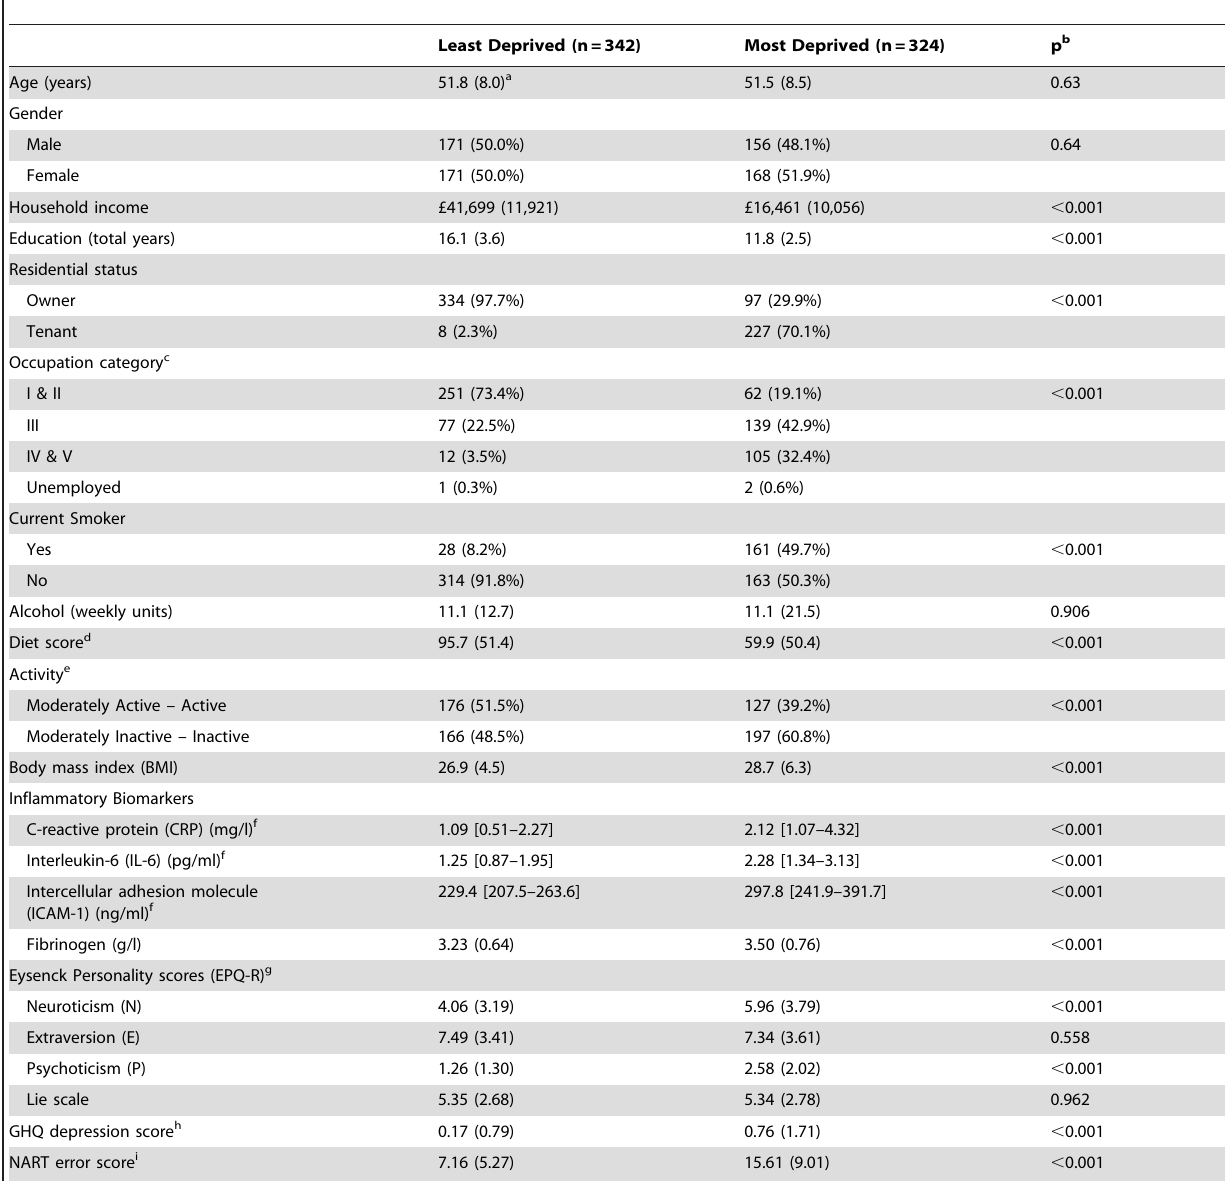
Table 1. Description of basic demographics, socioeconomic status, personality and markers of inflammation by area deprivation